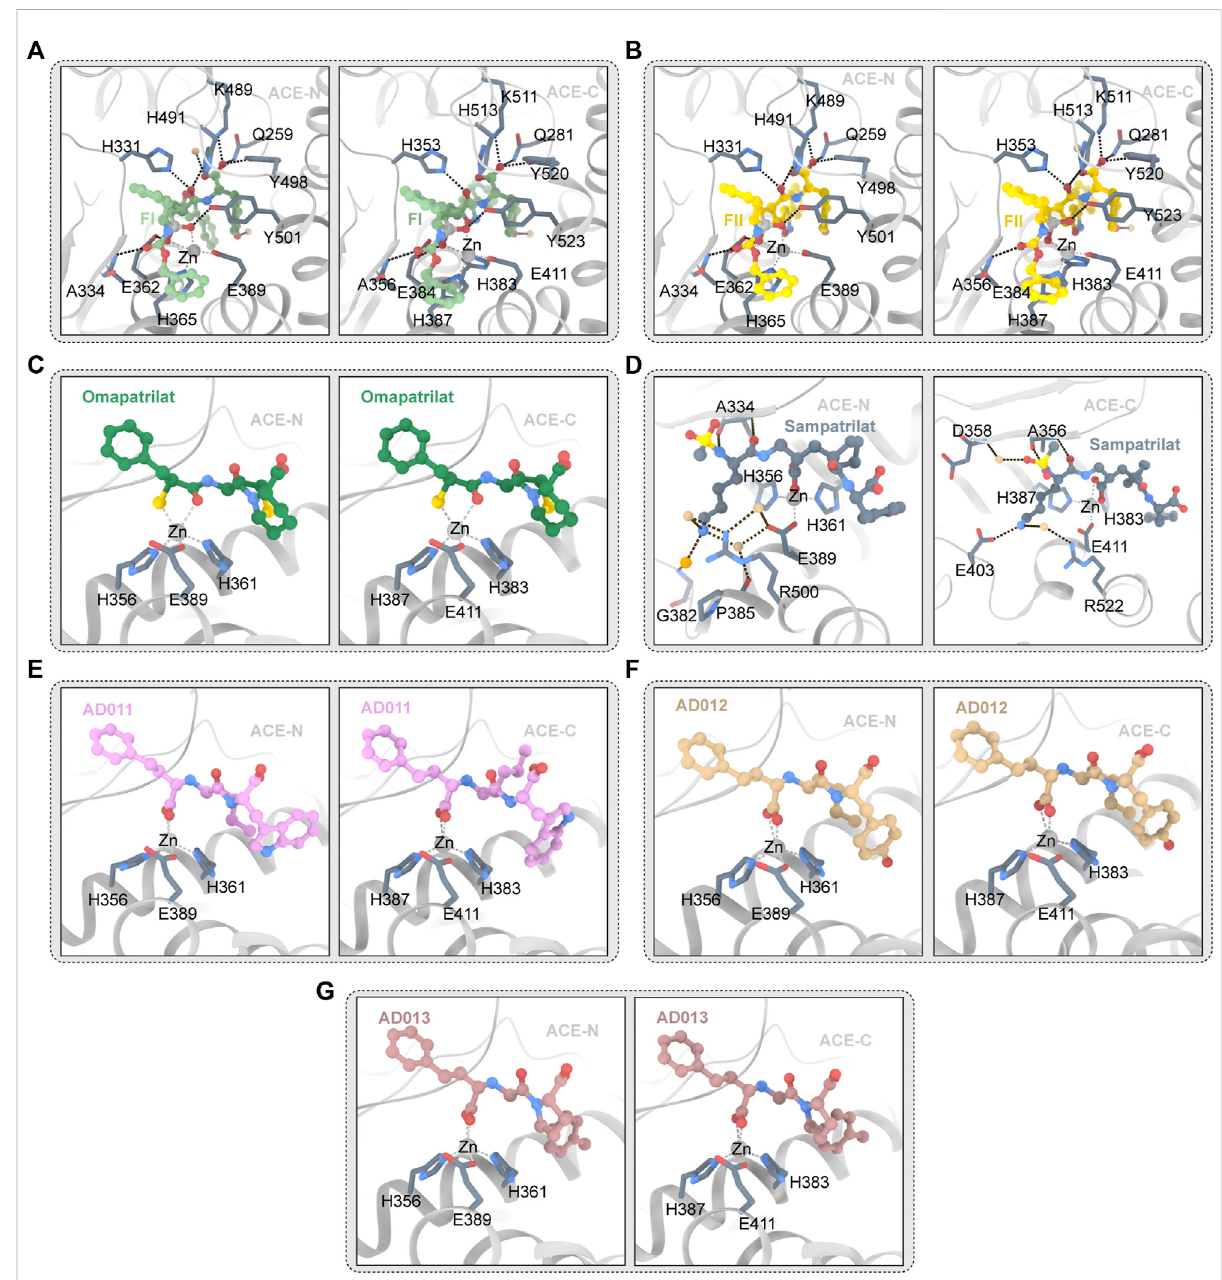
FIGURE 5 (A) FI and ACE (PDB ID:4CA5 4CA6) The ligand molecule is shown in green by balls and sticks. (B) FII and ACE (PDB ID:2XY9 2XYD) The ligand molecule is shown in yellow by balls and sticks. (C) Omapatrilat and ACE (PDB ID:6H5W 6H5X) The ligand molecule is shown in dark green by balls and sticks. (D) Sampatrilat and ACE (PDB ID:6F9T 6F9V) The ligand molecule is shown in grey by balls and sticks. (E) AD011 and ACE (PDB ID:7Q24 7Q27) The ligand molecule is shown in pink by balls and sticks. (F) AD012 and ACE (PDB ID:7Q25 7Q28) The ligand molecule is shown in